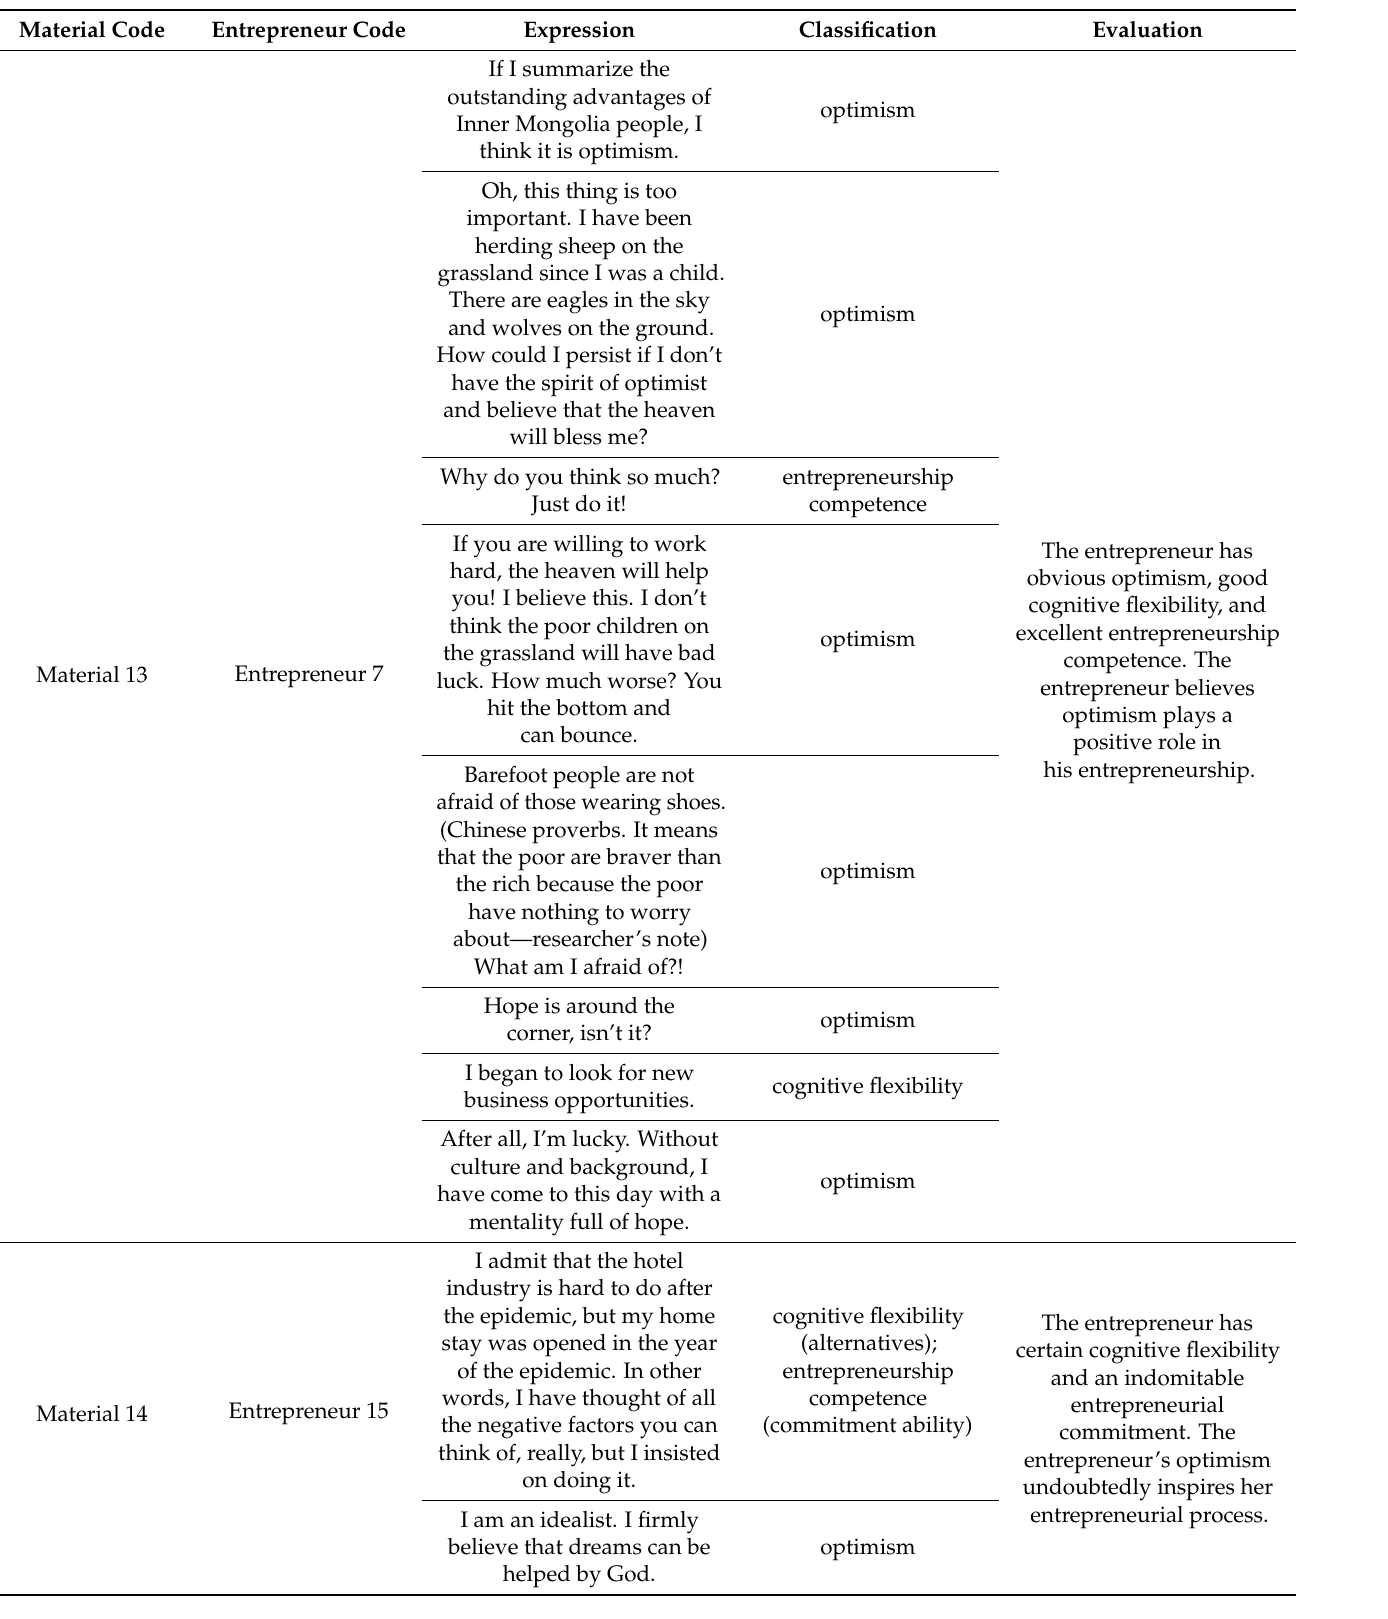
Table 4. Interview material distilling